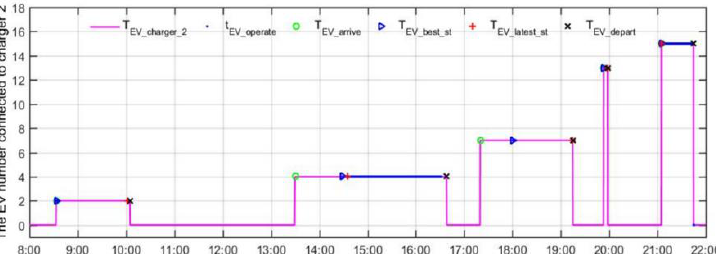
Figure 29. Operating time of EVs connected to charger 2 under SPVA.